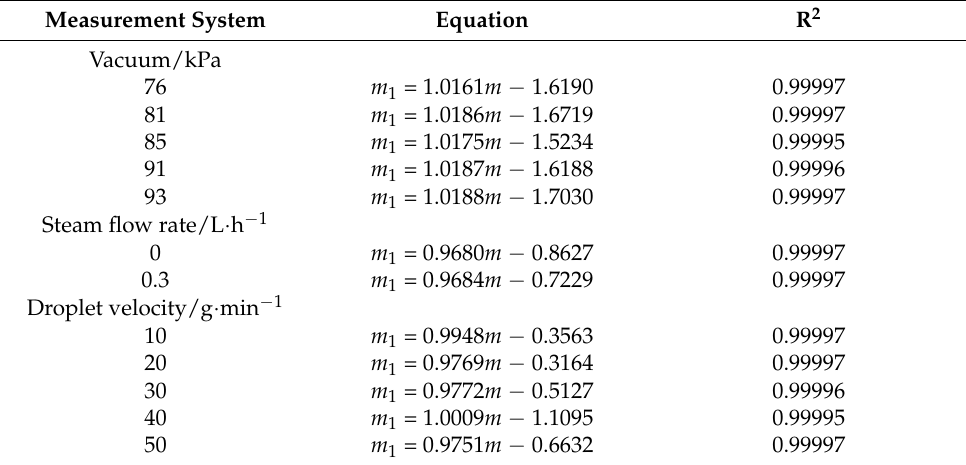
Table 4. Equation and coefficient of determination (R 2 ) under different experimental conditions.